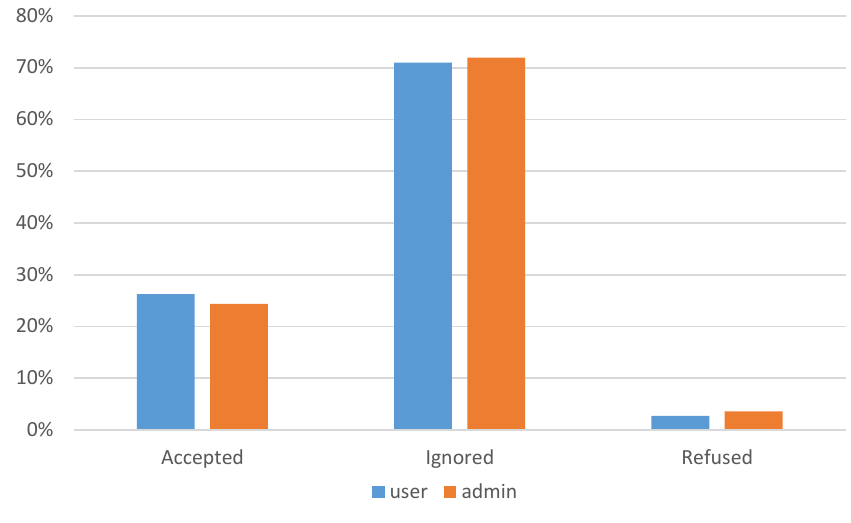
Figure 15. Participation in administrator’s task and user’s